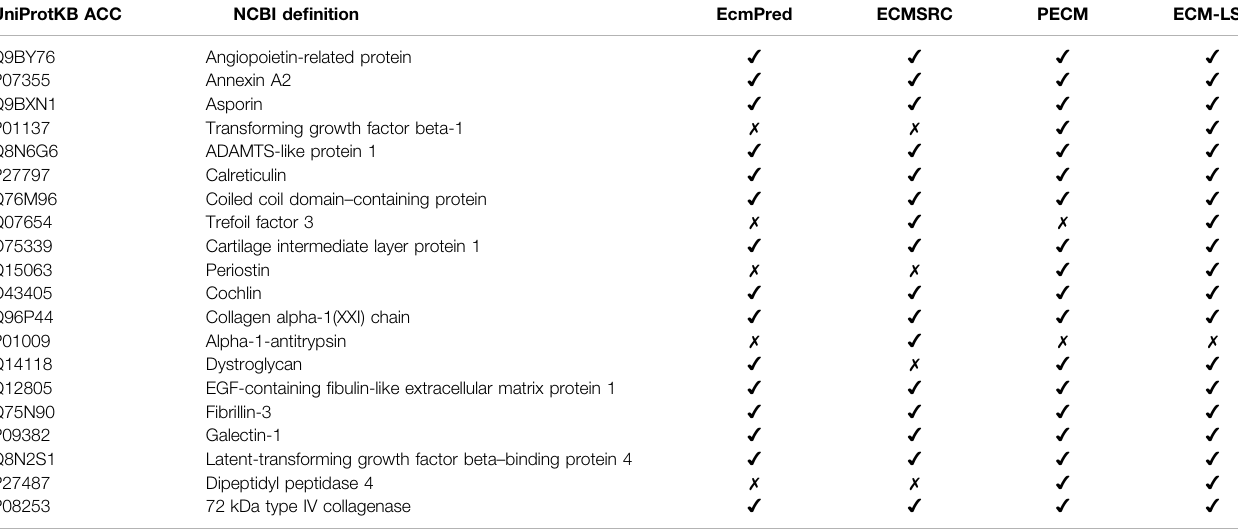
TABLE 3 | Prediction results for 20 experimentally veri fi ed ECM proteins. “ ✔ ” indicates correctly identi fi cation while “ 7 ” represents an incorrect identi fi cation. UniProtKB